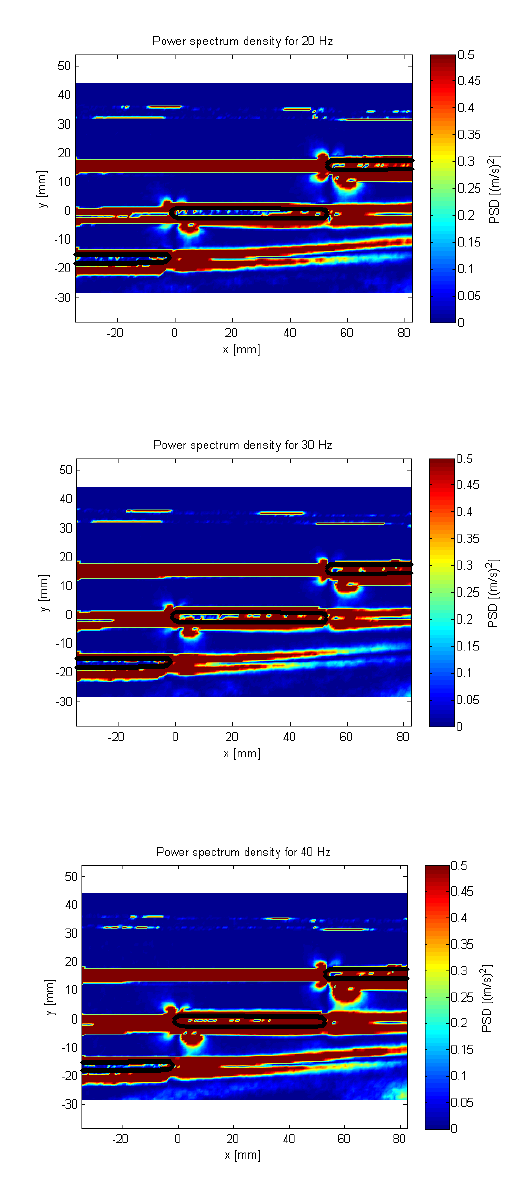
Fig. 8a, b, c. Phase angle ϕ=0, regimes I, III and V.